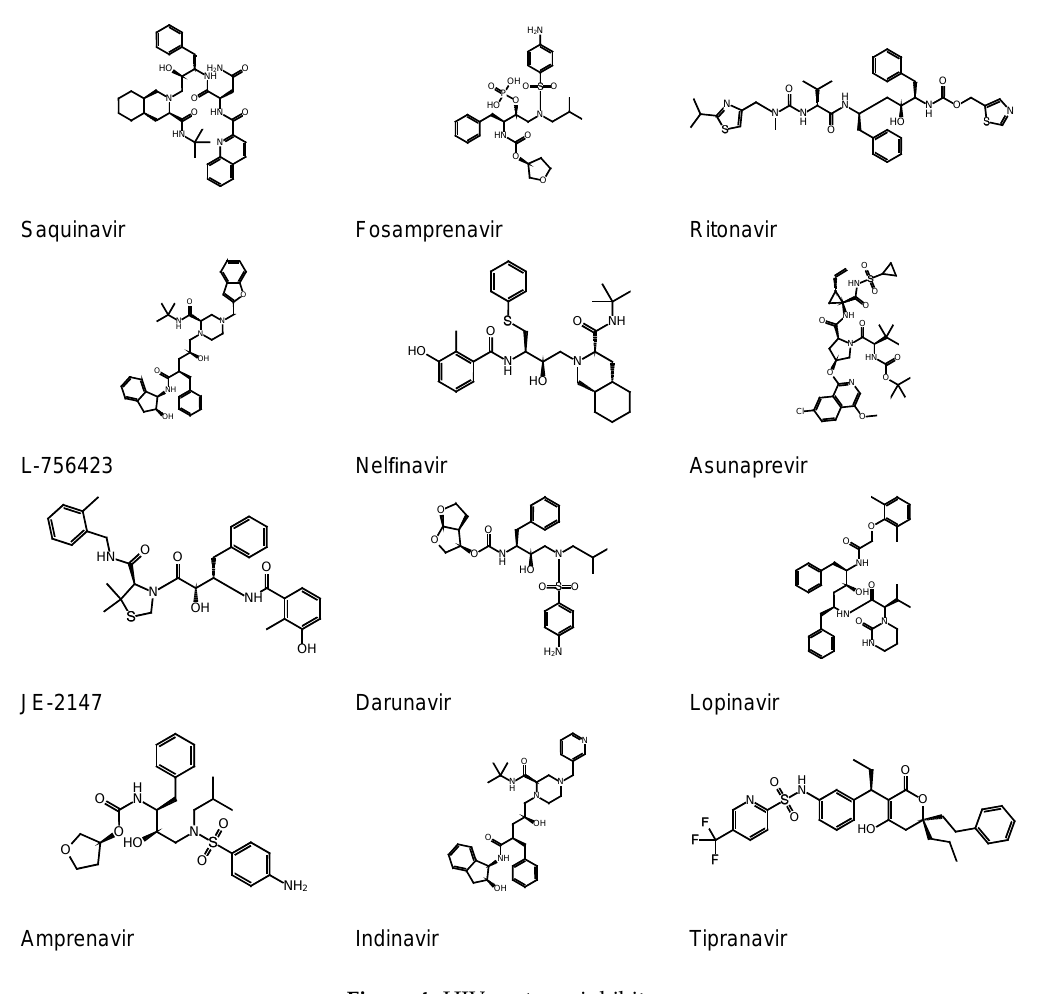
Figure 4. HIV protease inhibitors. Table 3. Biotarget a ffi nity scores (DAS) of known HIV inhibitors against COVID-19 M PRO and HIV-1 protease DRUDIT